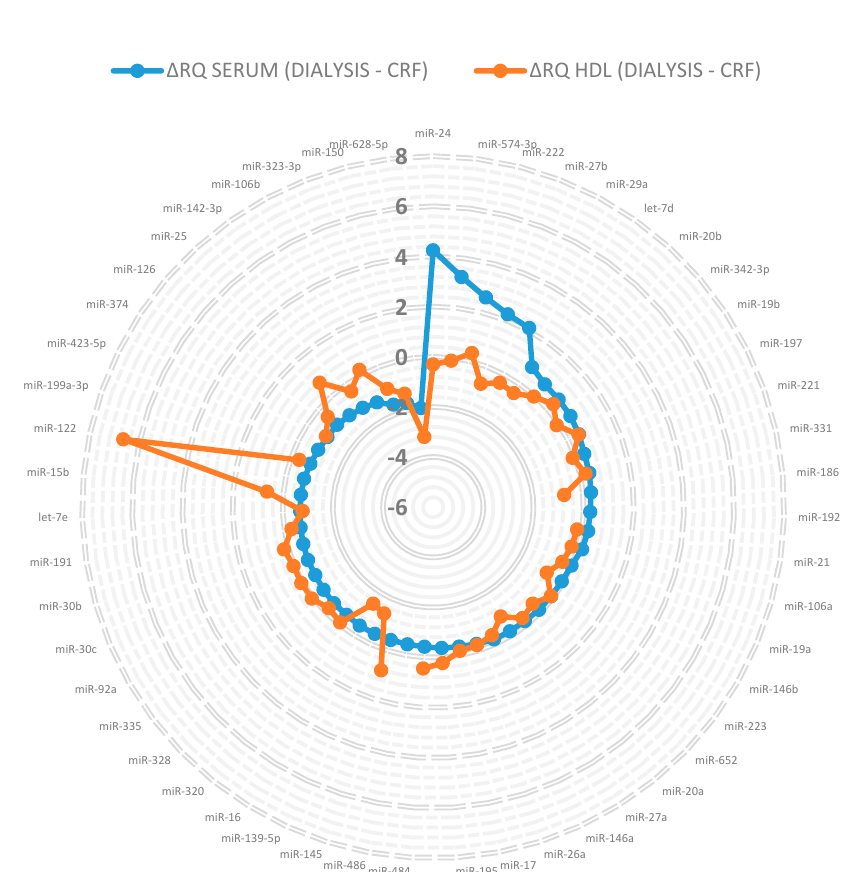
Figure 2. Differences in the miRNA profile in serum and HDL particles during disease progression from CRF to hemodialysis. Data is arranged in the following manner: starting at the twelve o’clock position with the maximum difference between the RQ values of serum (blue) during disease progression from CRF to hemodialysis (= Δ RQ), the values decrease clockwise (reaching nearly no change at the four o’clock position) and reach the maximum negative difference before closing the circle again (plotted are only miRNAs detectable in both disease progression steps). For comparison, Δ RQ values were superimposed for the same miRNAs (if available) in the HDL particle fraction (orange).